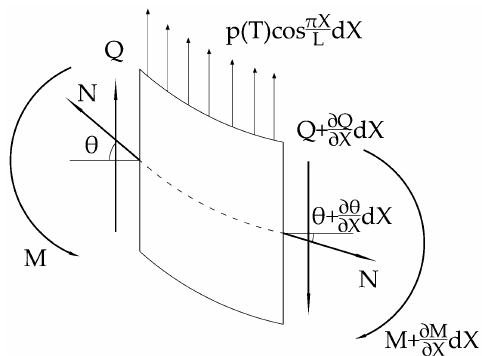
Figure 2. Dynamic equilibrium chart for a microbeam